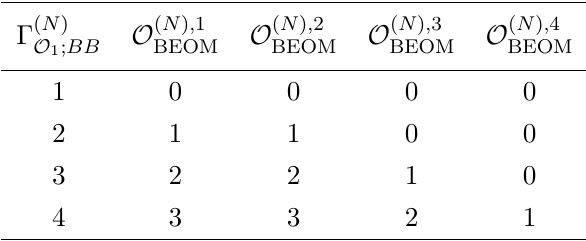
into O ( N ) ,k is required, 1 EOM